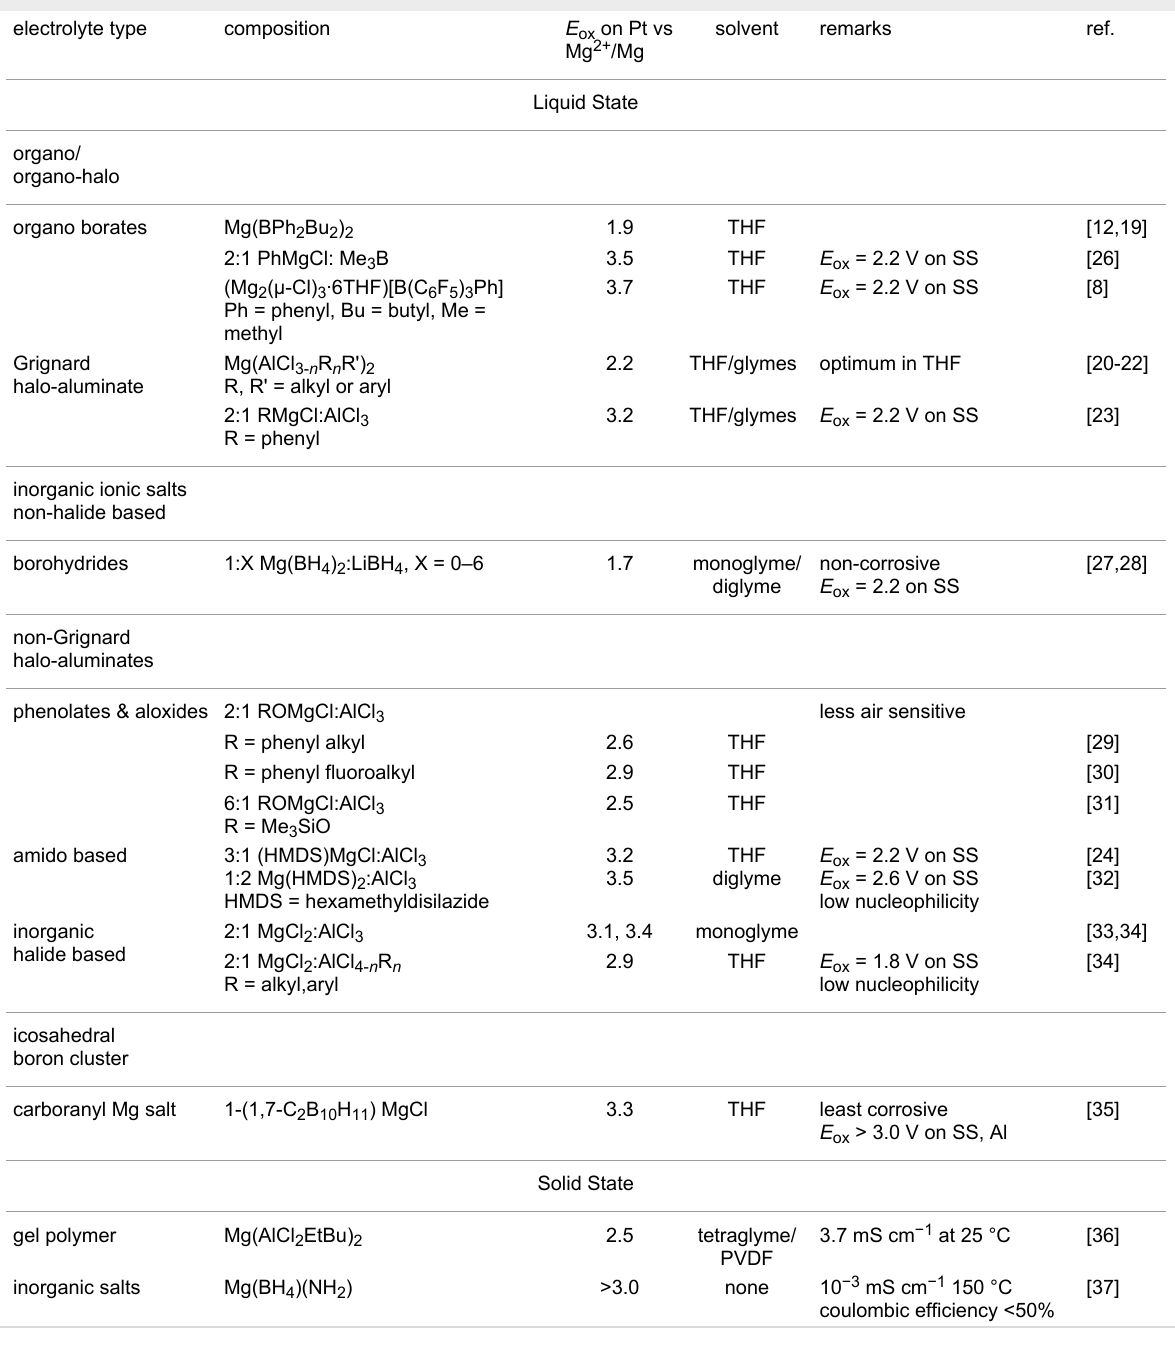
Table 1: Summary of Mg battery electrolytes based on their types. Properties of representative examples, including reported stability against oxi- dation E ox , are provided. electrolyte